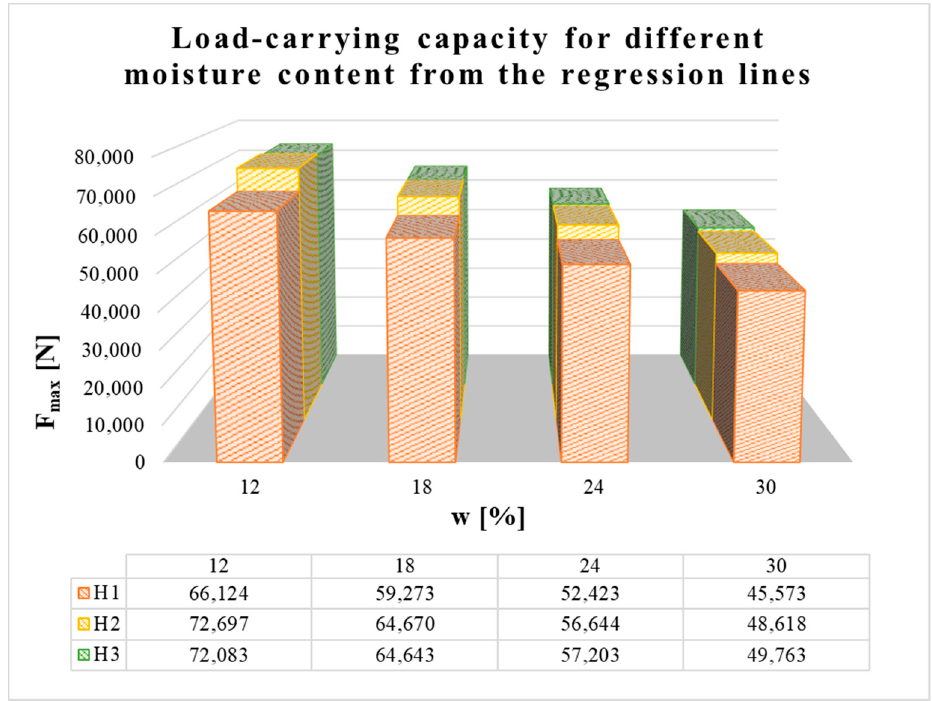
Figure 20. Load-carrying capacity for di ff erent moisture content from the regression lines.